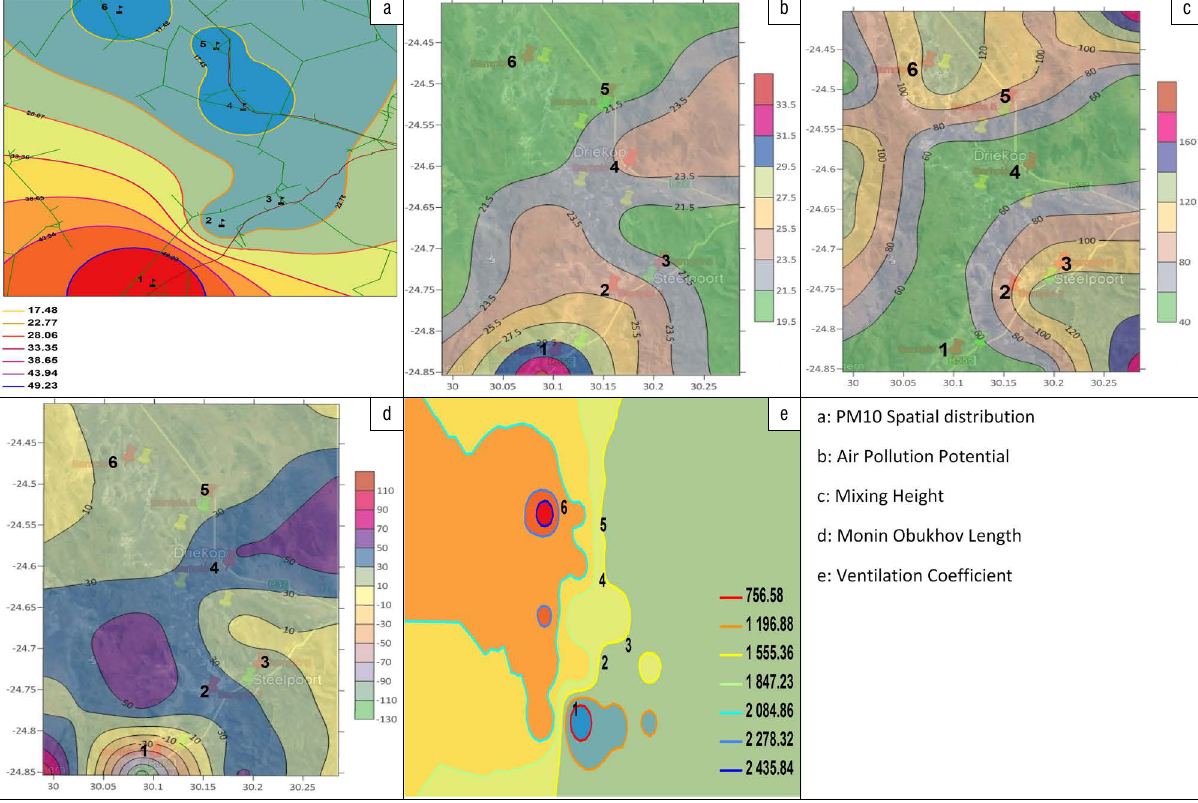
Figure 6: Influence of air pollution potential (APP), mixing height (MH), Monin–Obukhov length (MO) and ventilation coefficient on PM in